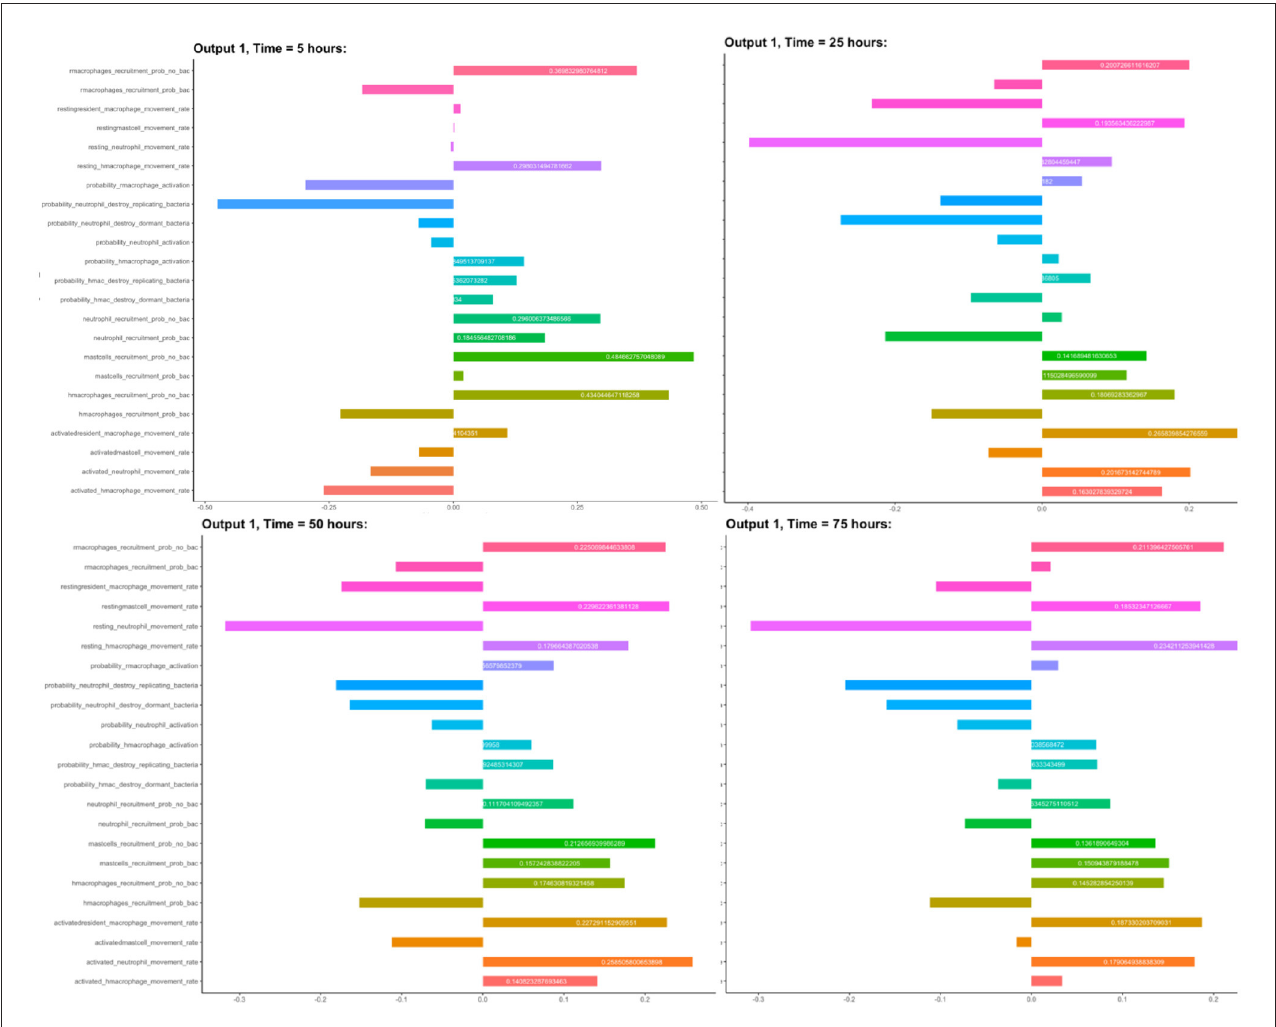
FIGURE3 Sensitivity analysis: PRCC values for all input parameters, using bacterial load as the